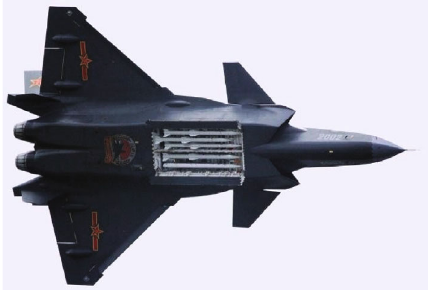
Figure 1: Weapon bay on